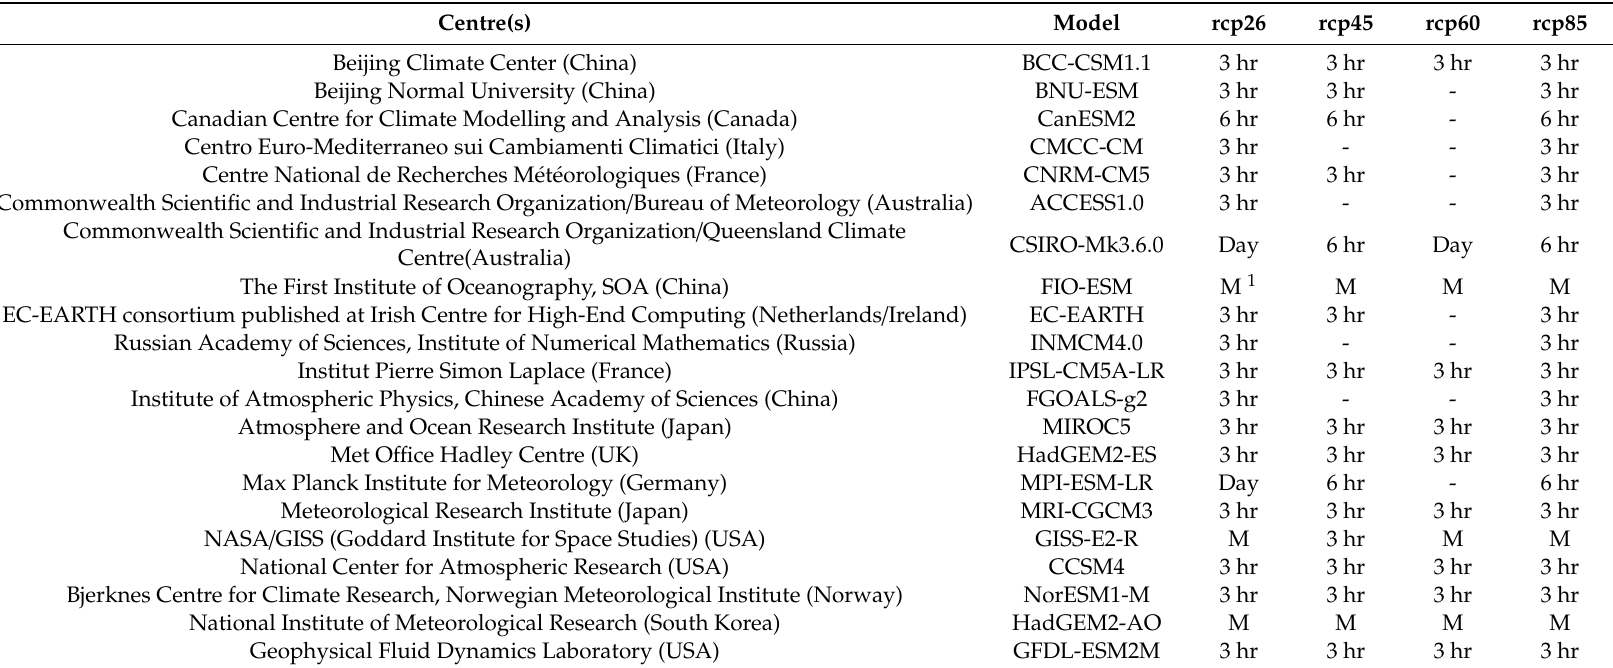
Table A1. Spatial resolutions of the IPCC climate